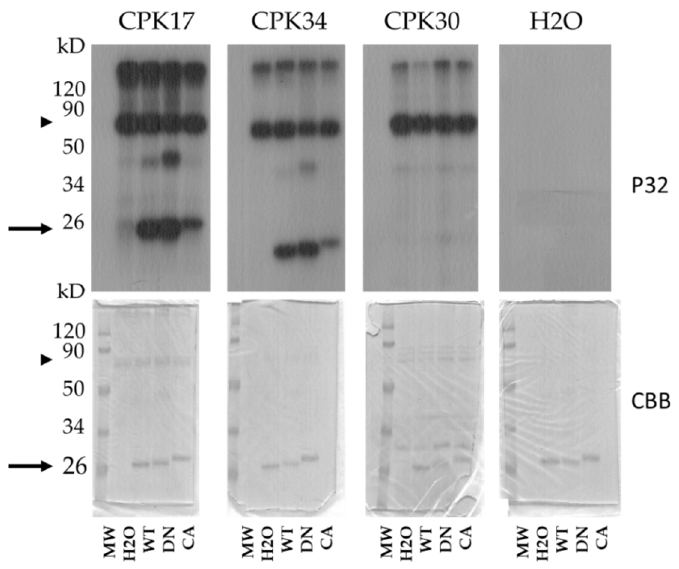
Figure 3. In vitro protein phosphorylation assays using the Arabidopsis CPK17, CPK 34, and CPK30 protein kinases and GDP-GTP-bound mutant forms of the AtROP1 GTPase (WT—wild type; DN—dominant negative; CA—constitutive active). The Coomassie Brilliant Blue (CBB)-stained gels are shown on the lower part, and their autoradiographs (P32) are above. The approximate position of the AtROP1 proteins on the gel/autoradiogram are shown by arrows and that of the CPK kinases by arrowheads. kD—molecular weight in kiloDaltons.